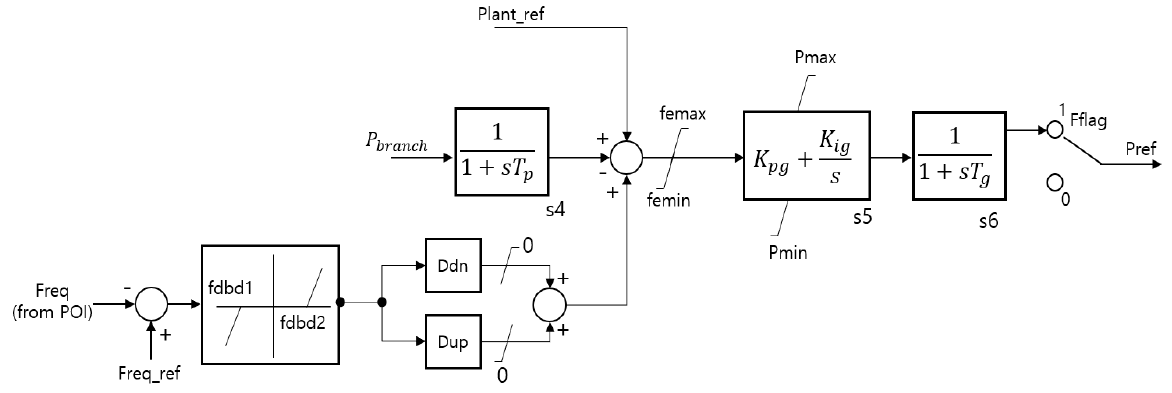
Figure A4. REPCAU1 model of PSS/E [15,16].